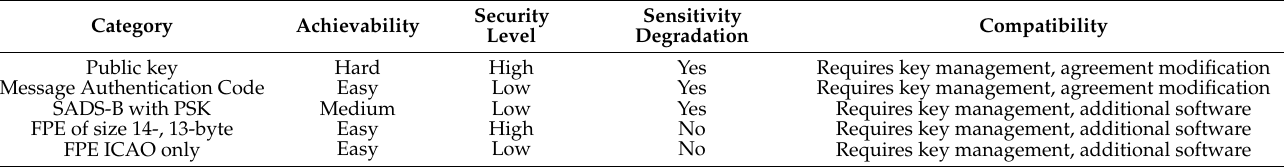
Table 3. Comparison of various solutions.